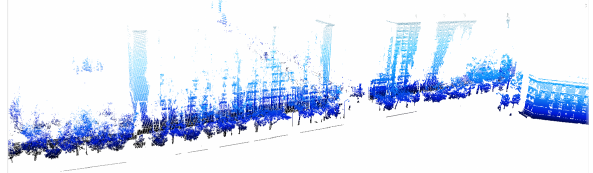
Figure 1: RIEGL laser point cloud acquired on a European urban